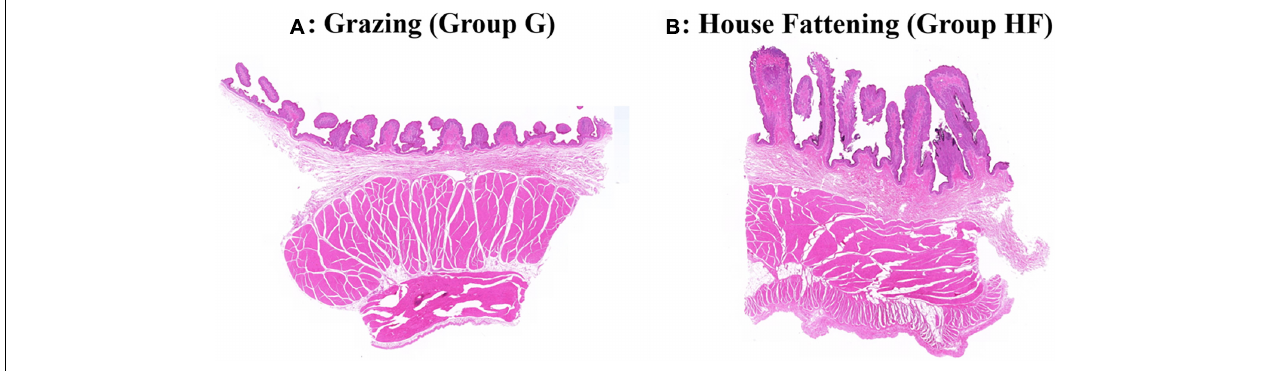
FIGURE 1 | Effects of different feeding systems on the morphological development of yak rumen. (A) The grazing group. (B) The house fattening group.